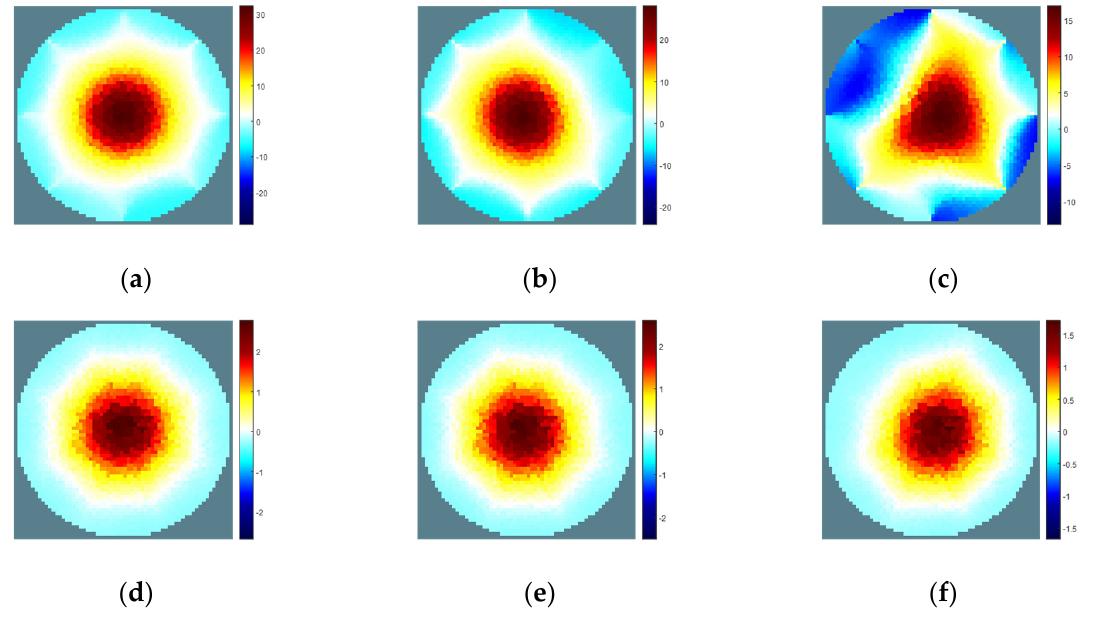
Figure 24. Reconstructed images of a metal inhomogeneity at the centre of EIT domain by varying the number of measurements of ( a ) 64, ( b ) 40, ( c ) 28 considering NOSER, and ( d ) 64, ( e ) 40, ( f ) 28 considering GHPP with λ = 0.17 at 5 kHz, 1 mA, and 2 Vpp excitation. The maximum conductivity changes was decreased by decreasing the number of measurements and a distorted reconstructed image was found for lower number of measurements using NOSER. The obtained maximum changes of conductivity using GHPF are 2.78, 2.57, and 1.72 S/m, respectively, whereas the changes are very high using NOSER.